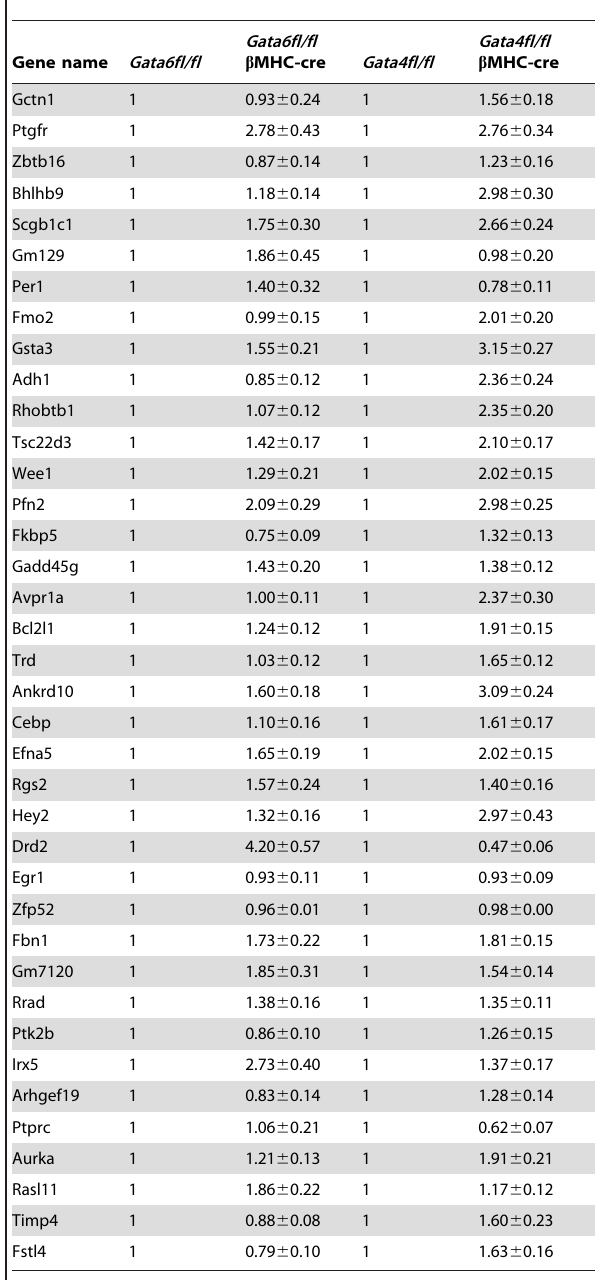
Table 3. qRT-PCR of differentially regulated angiogenesis and other